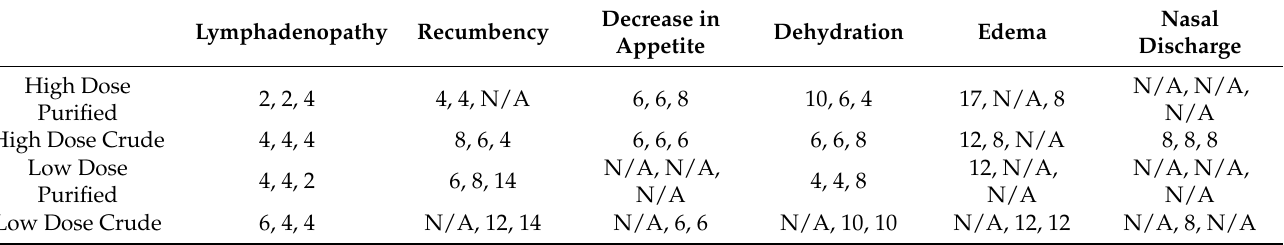
Table 2. Clinical signs and onset in cynomolgus macaques intravenously exposed to monkeypox virus by day of onset *.